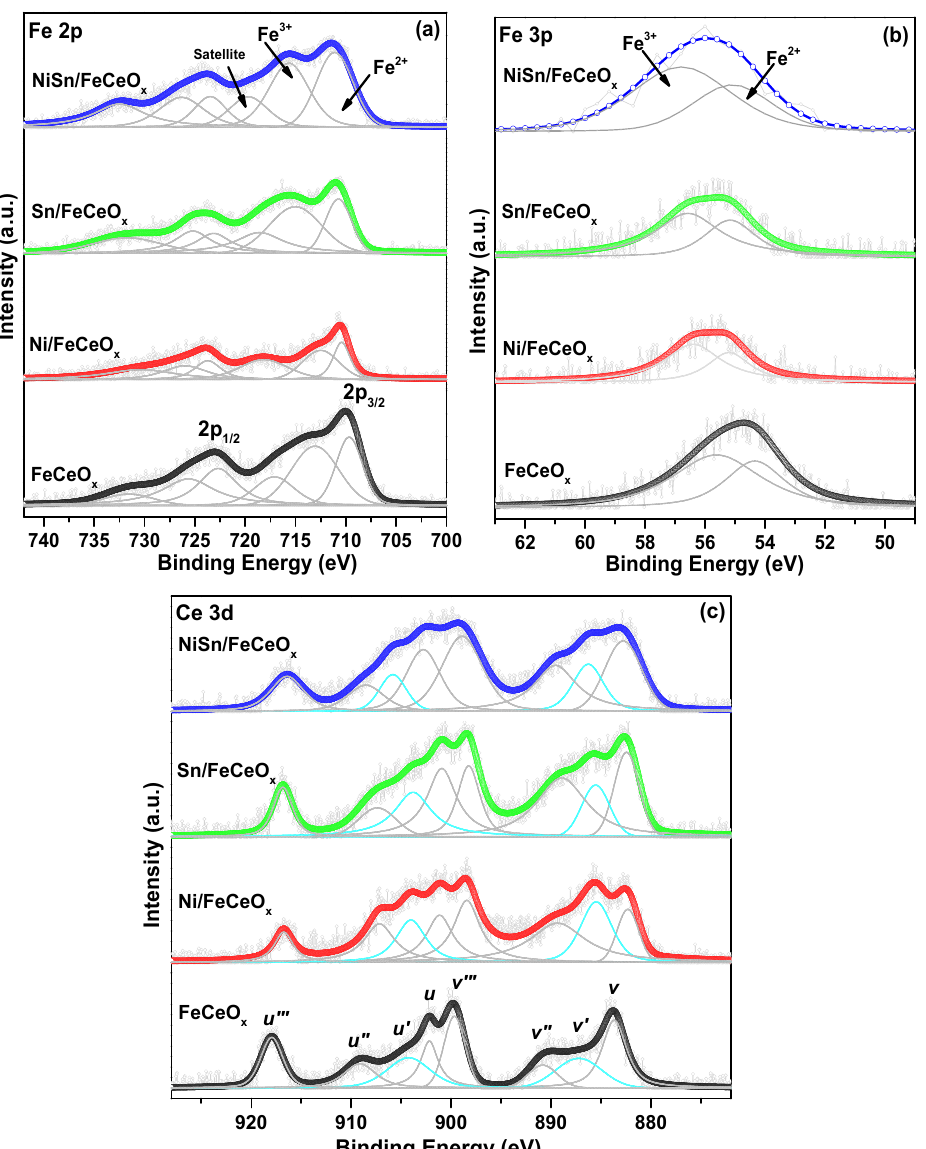
Figure 6. ( a ) Fe 2p ( b ) Fe 3p, and ( c ) Ce 3d XPS spectra of reduced FeCeO x , Ni/FeCeO x , Sn/FeCeO x , and NiSn/FeCeO x catalysts.